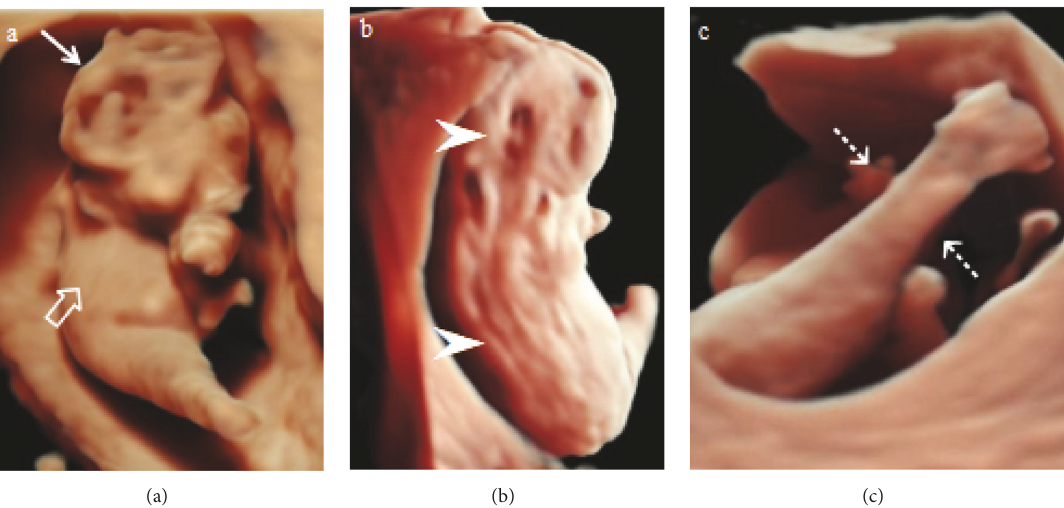
Figure 2: Three-dimensional HDlive rendering images at 17 weeks of gestation. (2a) Deformed and degenerated brain tissues are evident (white arrow). Absence of the right upper limb (white open arrow). (2b) The spine showed extensive clefts in the posterior part of the fetal vertebrae from the upper cervical region to the sacrum (white arrowheads). (2c) The lower extremities were completely fused, and the feet were fused with the heels, which were immobile (white dashed